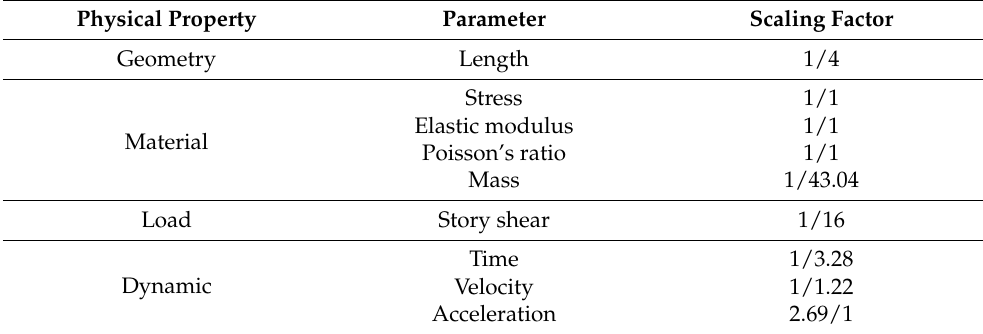
Table 4. Scaling rules of the CBF shake-table